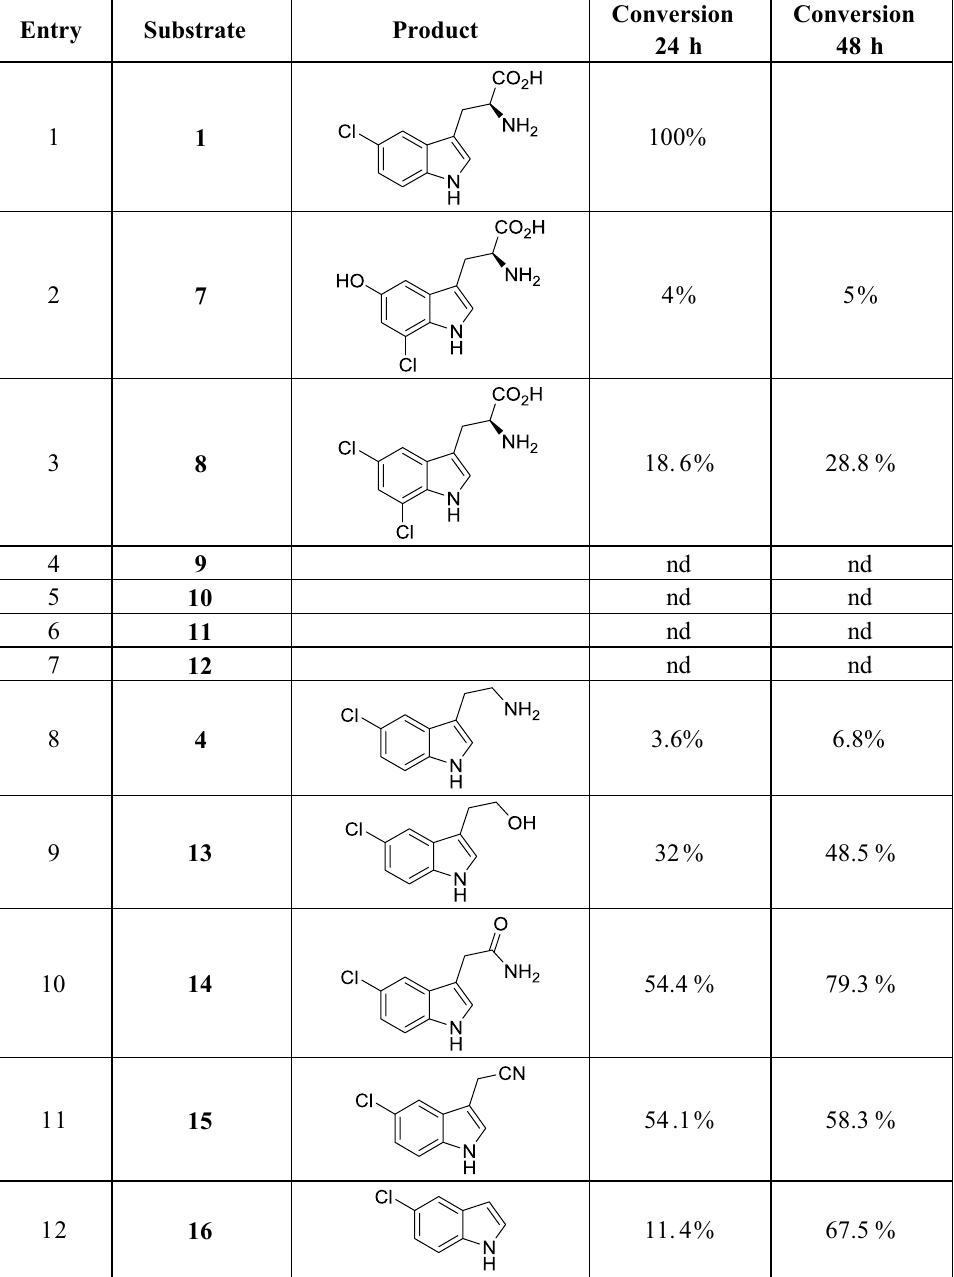
Table 1 Conversion of various substrates by Xszen FHal with NaCl